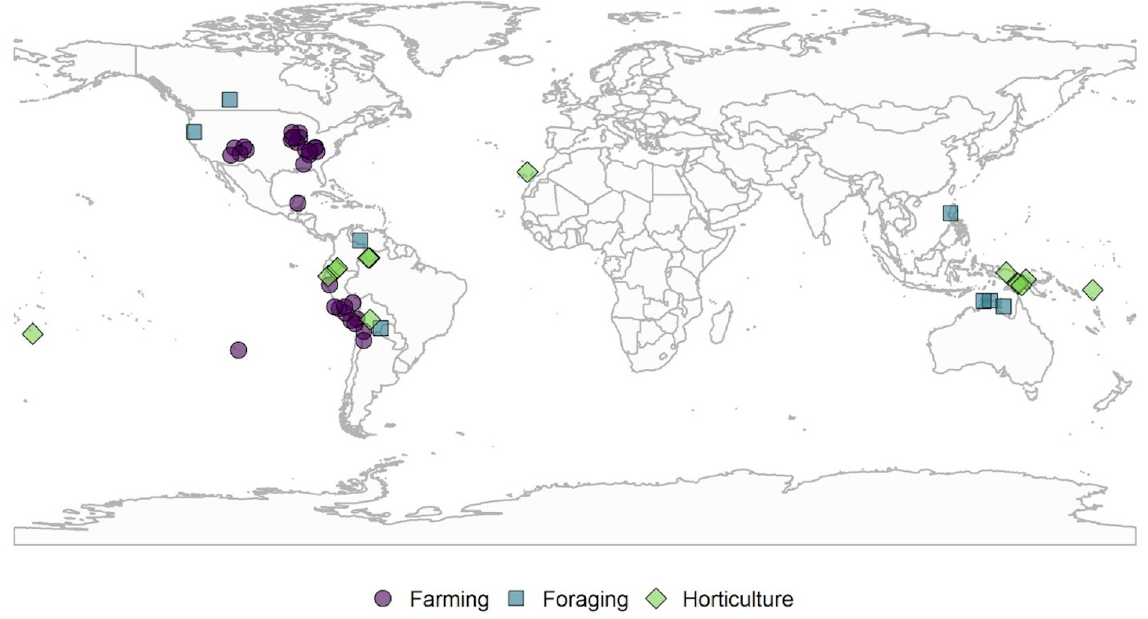
Fig 2. Map of observations. The global distribution of societies with violence data used in this study; color and shape coded by mode of subsistence.